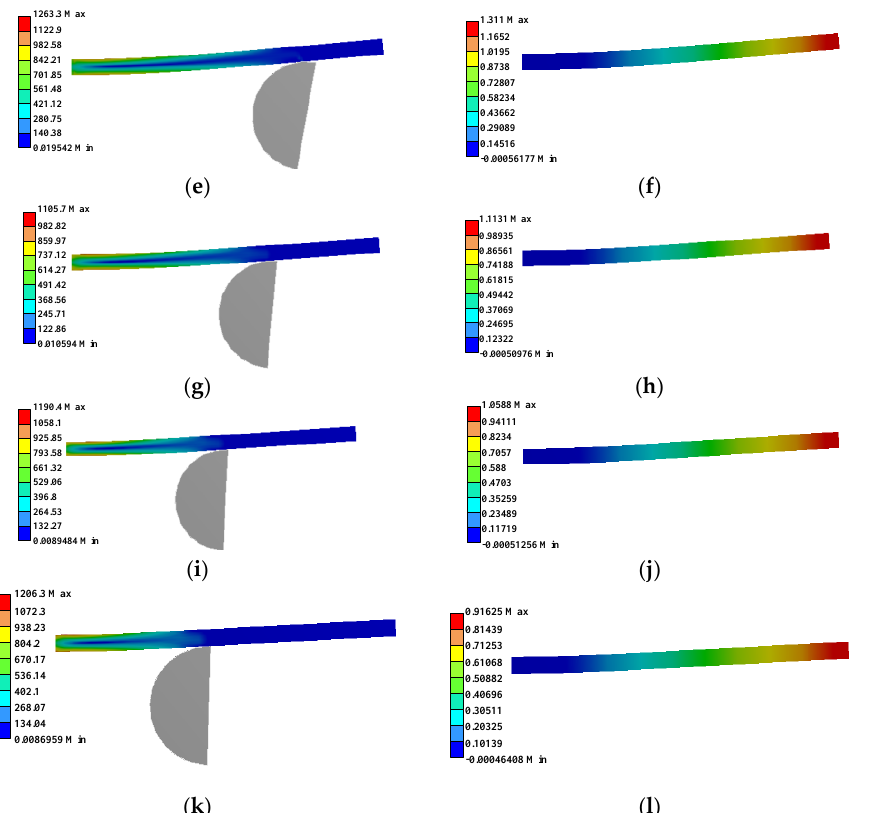
Figure 15. Stress (MPa) and deformation (mm) of leaf spring under different values of l . ( a , c , e , g , i , k , m , o , q ), and ( s ) are the stress results when l = 1, 3, 5, 7, 9, 11, 13 15, 17, 19 mm respectively. ( b , d , f , h , j , l , n , p , r ), and ( t ) are the deformation results when l = 1, 3, 5, 7, 9, 11, 13 15, 17, 19 mm respectively.